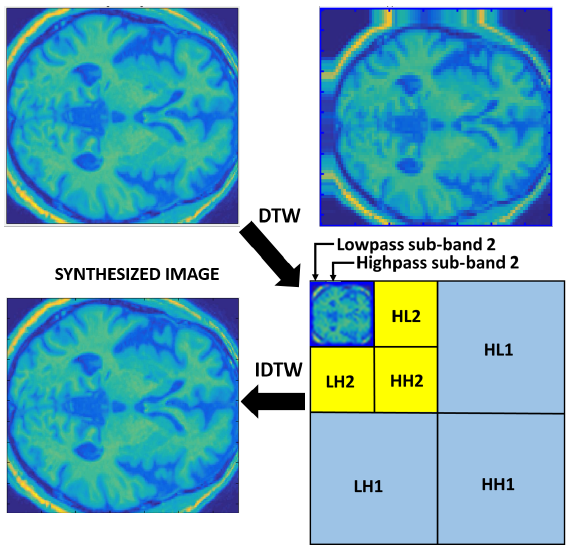
Figure 3. Operating mode of the 2D wavelet transform applied to